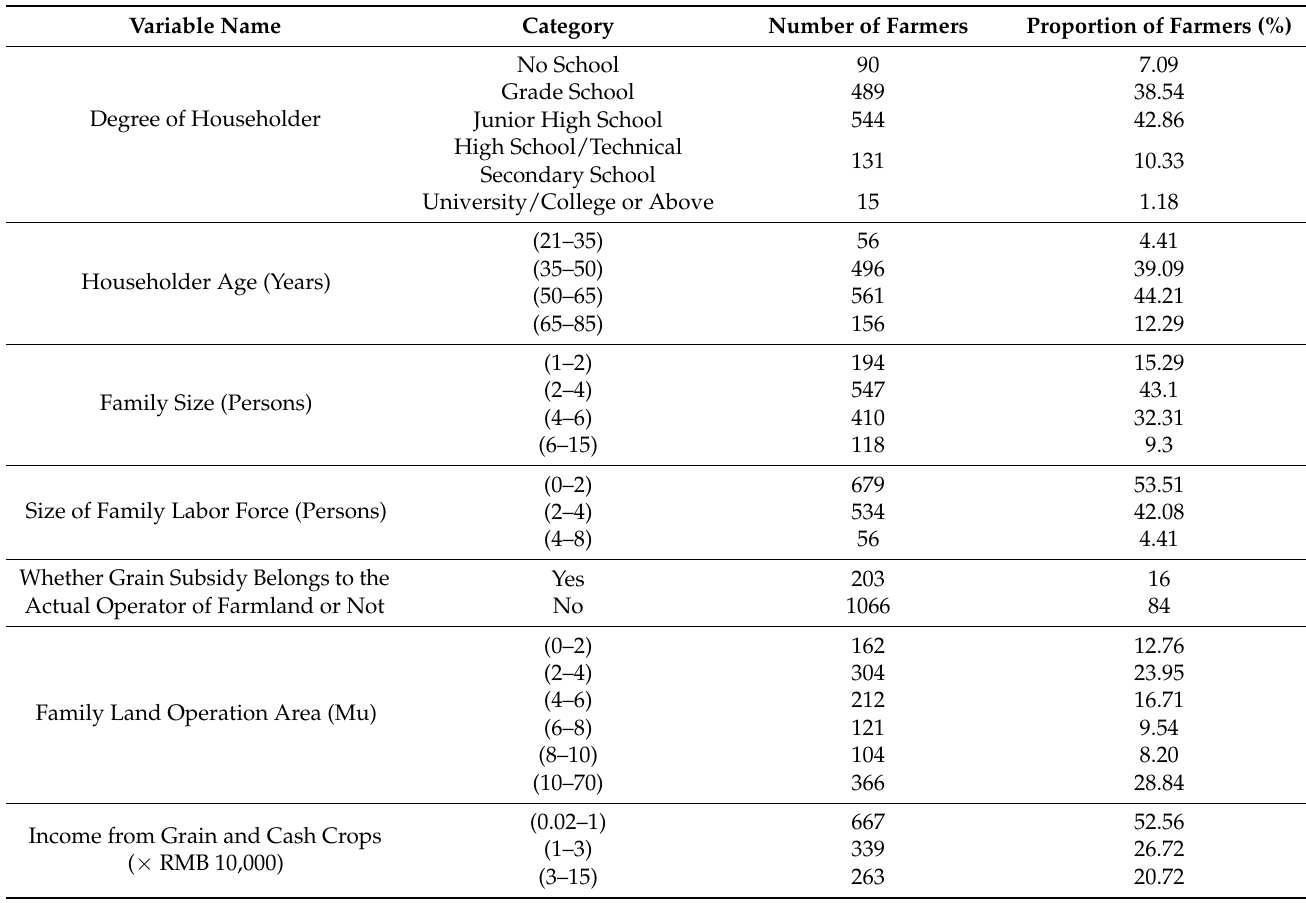
Table 1. Basic Characteristics of Sample